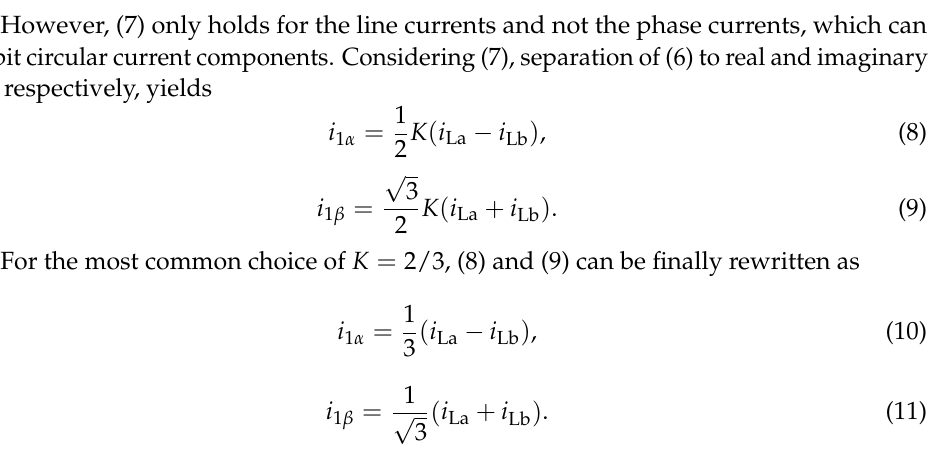
Figure 1. Three-phase winding: ( a ) star connection; ( b ) delta connection.